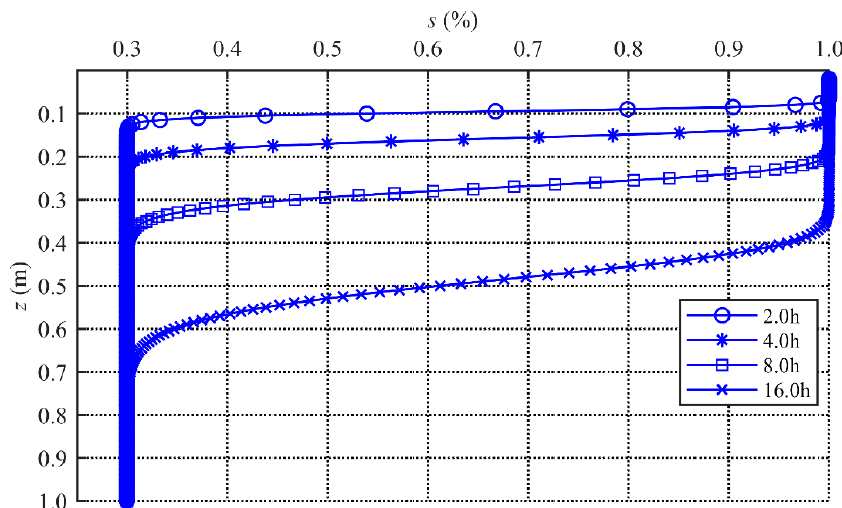
Figure 10. Saturation profiles at different times.